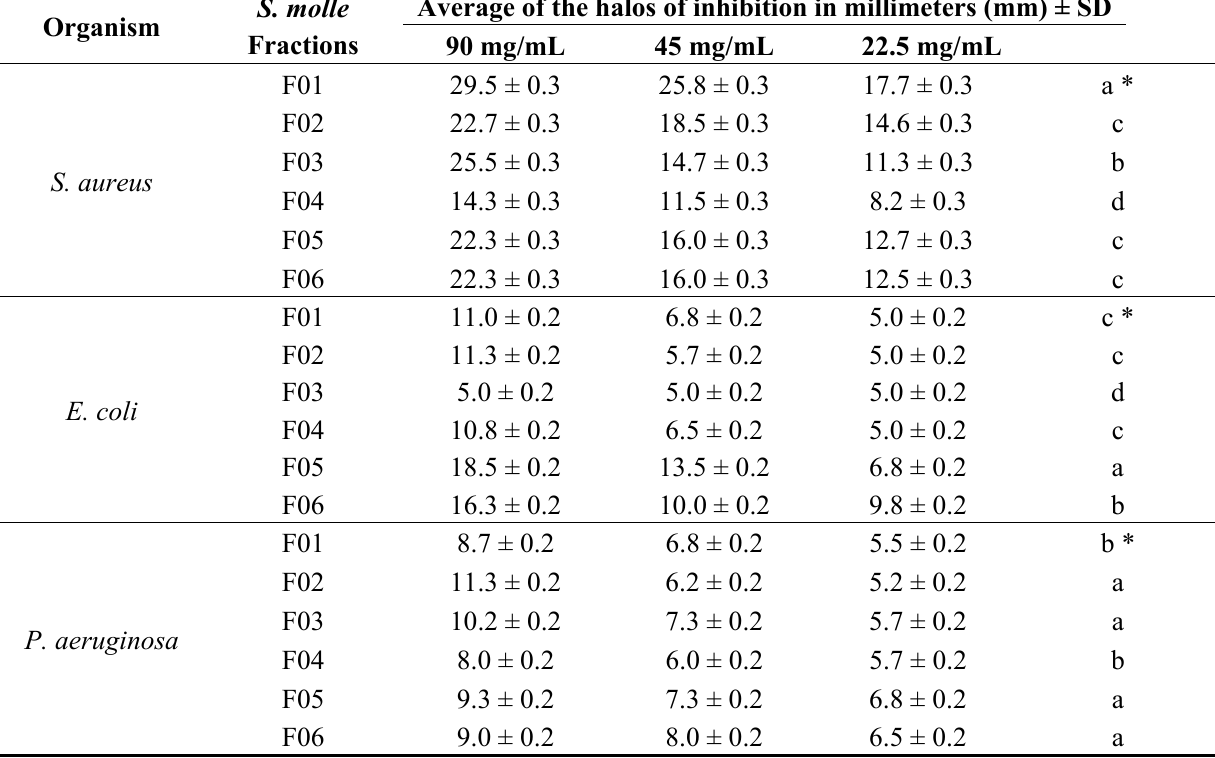
Table 7. Results expressed as mean diameters of the inhibition halos in millimeters (mm) ± standard deviation (Tukey’s test at 5% probability). Organism